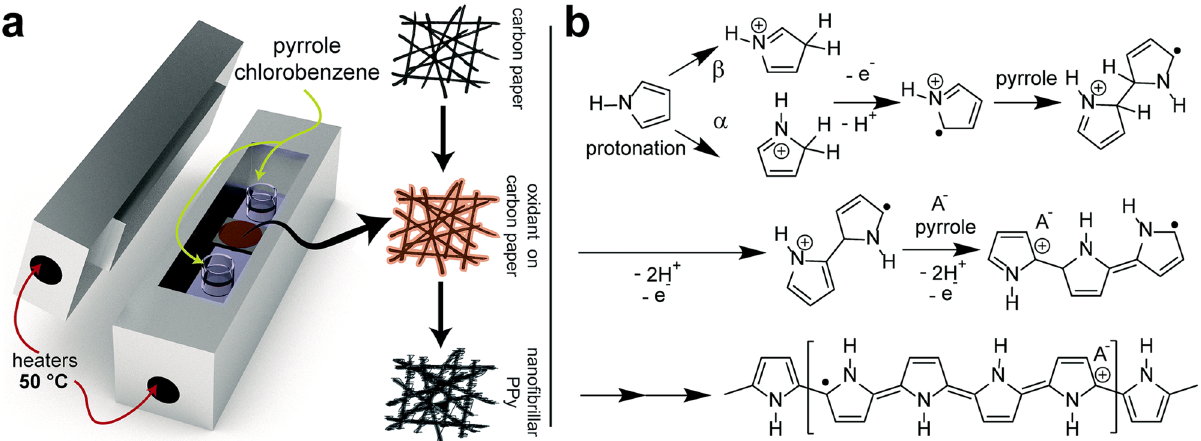
Figure 7. ( a ) A schematic of evaporative vapor phase polymerization, ( b ) An acid-catalyzed chain- growth mechanism of polymerization for pyrrole [155]. Copyright 2017 Journal of Materials Chem- istry A.